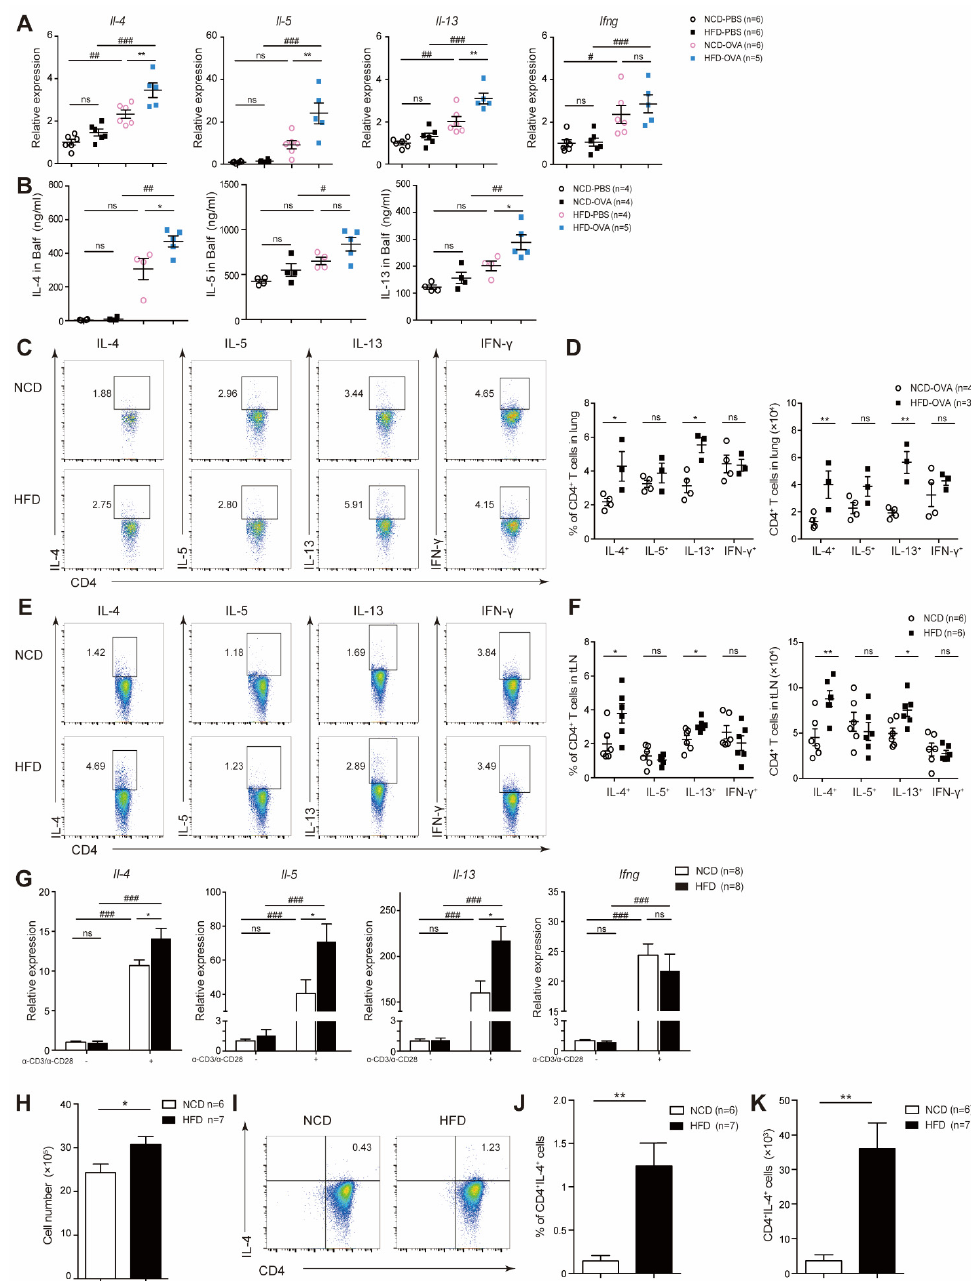
Figure 3. Offspring of mice fed high-fat diet during pregnancy exhibited increased T H 2 cytokine level. ( A – F ) OVA model. ( A ) Il-4 , Il-5 , and Il-13 mRNA expression levels in lungs. ( B ) Concentration of IL-4, IL-5, and IL-13 in BALFs. CD4 + IL4 + T-cells, CD4 + IL5 + T-cells, CD4 + IL13 + T-cells, and CD4 + IFN γ + T-cells in lungs ( C , D ) and tLNs ( E , F ). ( G – K ) Naïve CD4 + T-cells were sorted out from spleen and stimulated with anti-CD3/anti-CD28 in vitro. ( G ) Il-4 , Il-5 , Il-13 , and Ifng mRNA expression levels on stimulation for 3 h. ( H – K ) Splenic naïve CD4 + T-cells were differentiated under type 2 T helper cells (T H 2)-skewed conditions for 5–7 days. ( H ) Cell numbers on day 6. Cells were collected and restimulated by phorbol 12-myristate 13-acetate (PMA), ionomycin, and GolgiPlug for 5 h. Percentage ( I , J ) and quantifications ( K ) of CD4 + IL4 + T-cells. p values were determined by a one-way